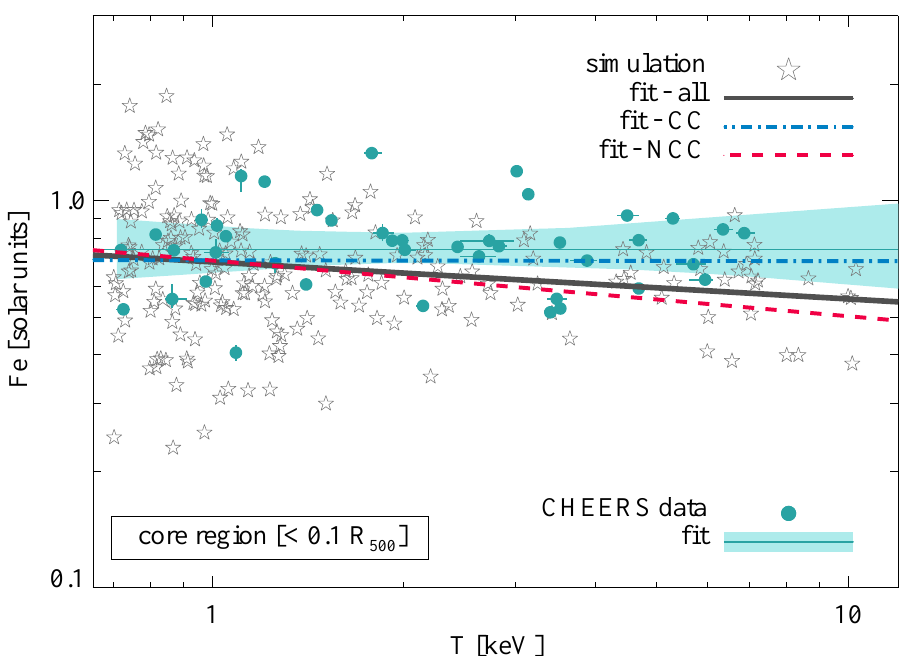
Figure 12. Relation between gas iron abundance and temperature in the core ( r < 0.1 R 500 ) of groups and clusters. Comparison between cosmological simulations (empty stars) and X-ray observational results from the CHEERS sample (filled circles). We also report best-fit relations for the whole simulated sample (solid grey line), and for the CC and NCC subsamples (blue dot-dashed and red dashed lines, respectively), as well as the relation determined from the CHEERS data (turquoise line and shaded area, for the associated 68.3% confidence region). Consistently with previous sections, iron abundances, relative to hydrogen, are reported with respect to the Solar reference value by Reference [43]. Adapted from Reference